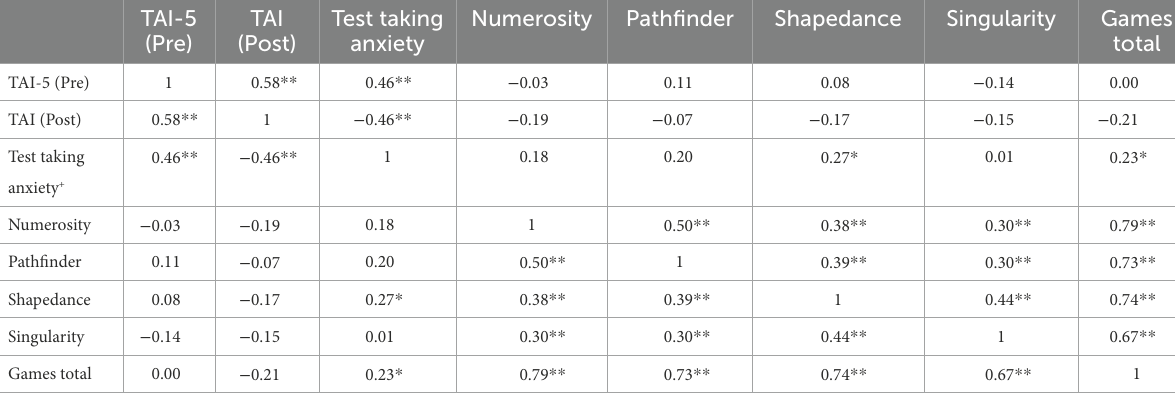
TABLE 6 Correlations between test taking anxiety and game performance.